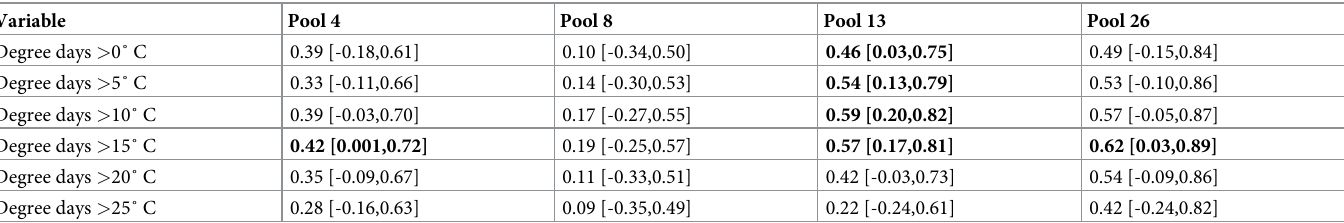
Table 2. Pearson’s correlation coefficients with 95% confidence intervals between year and degree days of air temperature. Sample size for Pools 4 and 8 is 22. Sample size for Pool 13 is 20. Sample size for Pool 26 is 11. Bold indicates a 95% confidence interval that does not overlap